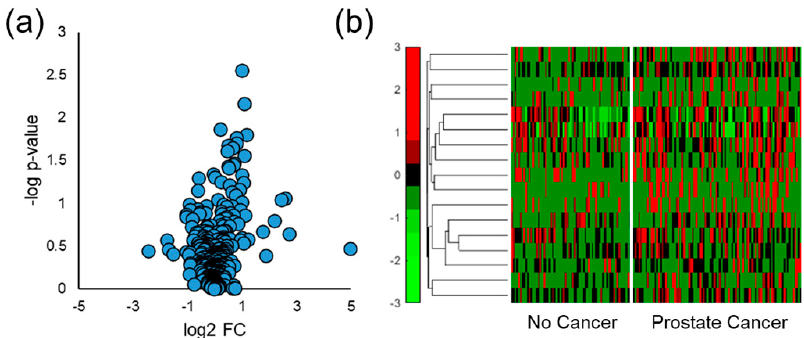
Figure 3. Univariate chemometric analysis of human urine for VOC biomarker identification regarding any grade/stage of prostate cancer. ( a ) The volcano plot shows that more VOCs are upregulated by prostate cancer in human urine relative to those that are downregulated, and ( b ) the hierarchical heatmap of VOCs identified with a p -value < 0.05 shows that the analytes have high variation regardless of prostate cancer diagnosis.